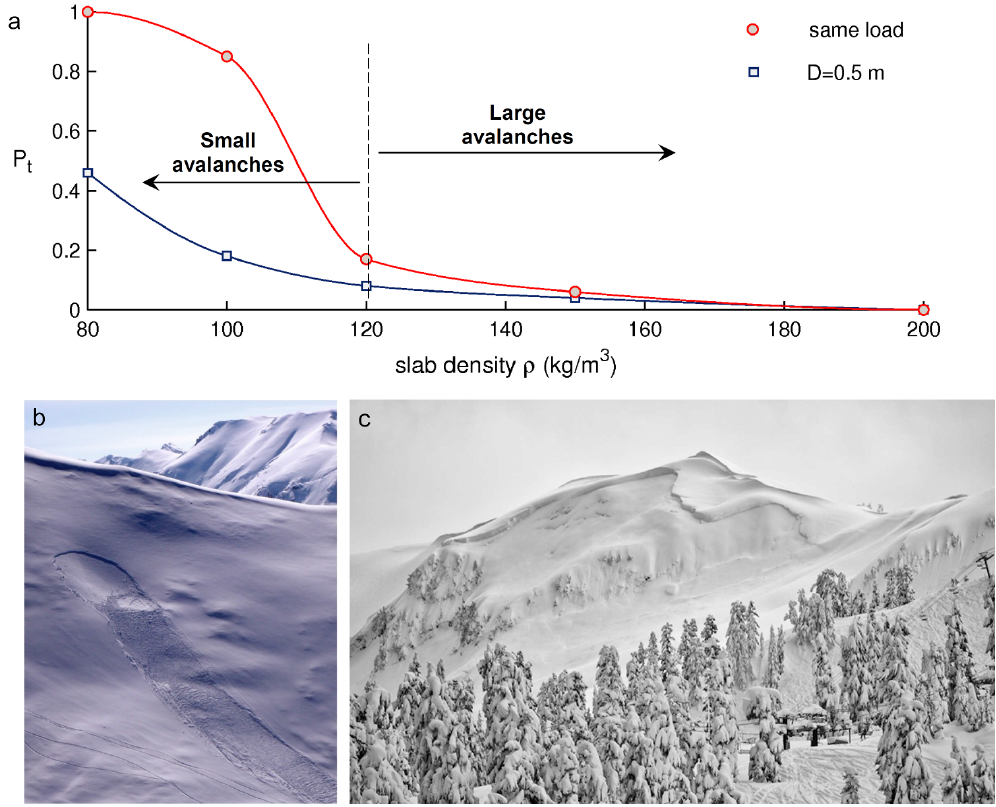
Figure 6. Slab tensile failure probability P t vs. slab density for (cid:15) = 2m and taking into account the relation between slab density ρ , its Young’s modulus E and its tensile strength σ t according to Eqs. (2) and (3). The red curve represents the results of simulations for a constant load and thus a slab thickness which decreases with slab density ( ρD = 100kgm − 2 ). The blue curve represents a constant slab thickness D = 0 . 5m and thus a varying load. Below are two avalanche pictures illustrating the result: (left) soft and shallow slab of small size ( © Anchorage Avalanche Center); (right) hard and thick slab with a very large extent ( © Grant